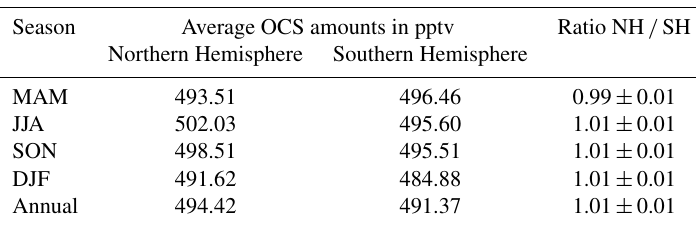
Figure 9. Left: OCS latitude–height cross sections measured by MIPAS between 2002 and 2012 during December to February, March to May, June to August and September to November (top to bottom). Middle: same as left but for EMAC OCS model results. Right: same as left, but for EMAC OCS model results convolved with a MIPAS averaging kernel of a tropical OCS profile. Table 2. Seasonal and annual averages of OCS amounts measured by MIPAS between June 2002 and April 2012 in the northern and southern hemispheric troposphere and the ratio between hemispheric averages. MAM: March to May, JJA: June to August, SON: September to November, DJF: December to